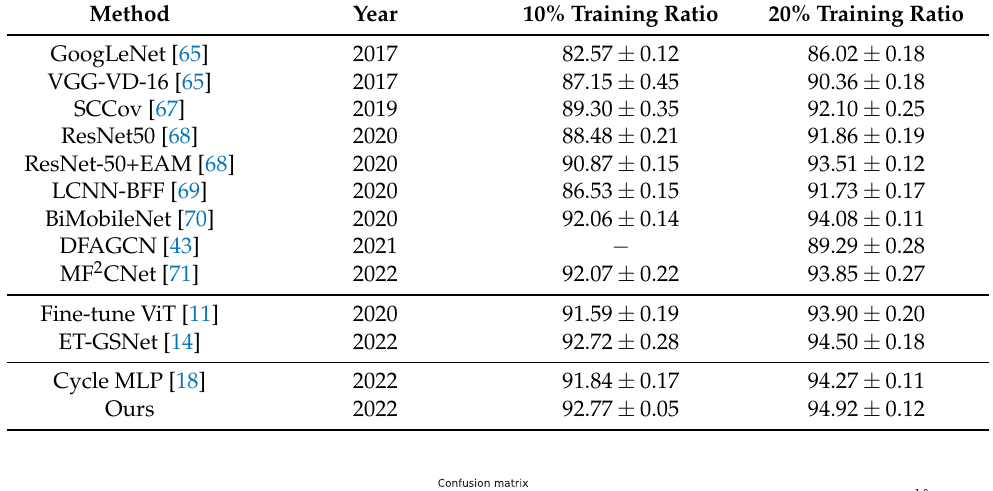
Table 4. The comparison of OA on the NWPU Dataset.